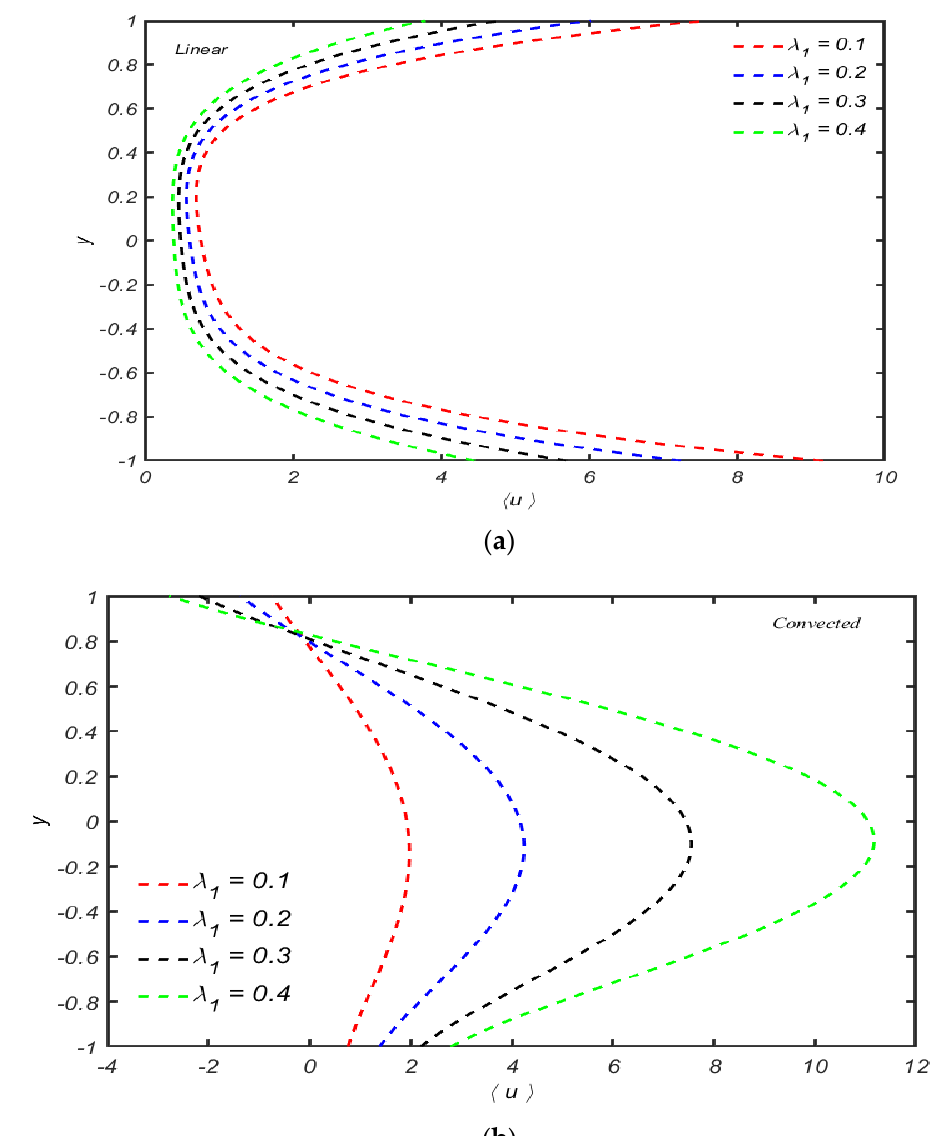
Figure 6. ( a ): The behavior of the mean axial velocity distribution for several values λ 1 . When other parameters are R = 10, α = 0.5, χ = 0.05. ( b ) Variation of the axial velocity distribution for several values λ 1 with R = 10, α = 0.5, χ =